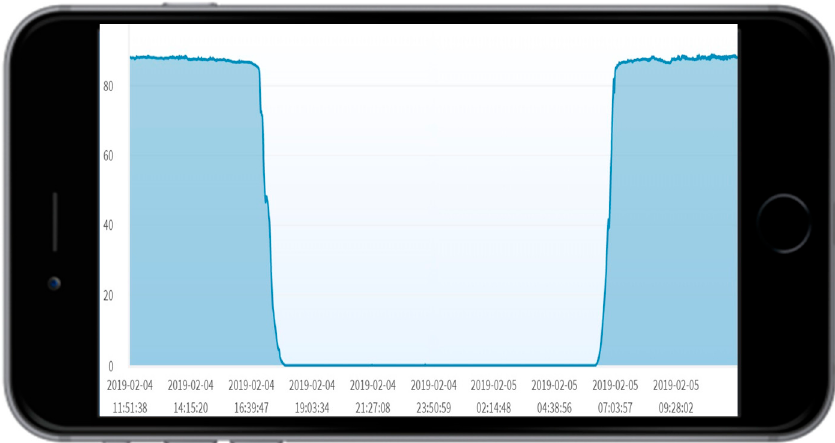
Figure 8. The time series chart of the output device feature (ODF) monitor (from Lum-I to